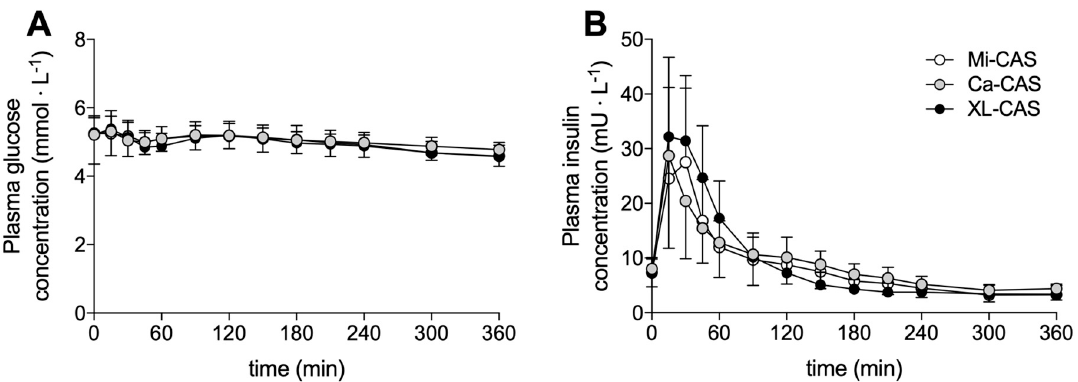
Figure 2. Plasma glucose ( A ) and insulin ( B ) concentrations. Means ± SD ( n = 15). Ca-CAS: caseinate protein; XL-CAS: cross-linked casein protein; Mi-CAS: micellar casein protein.